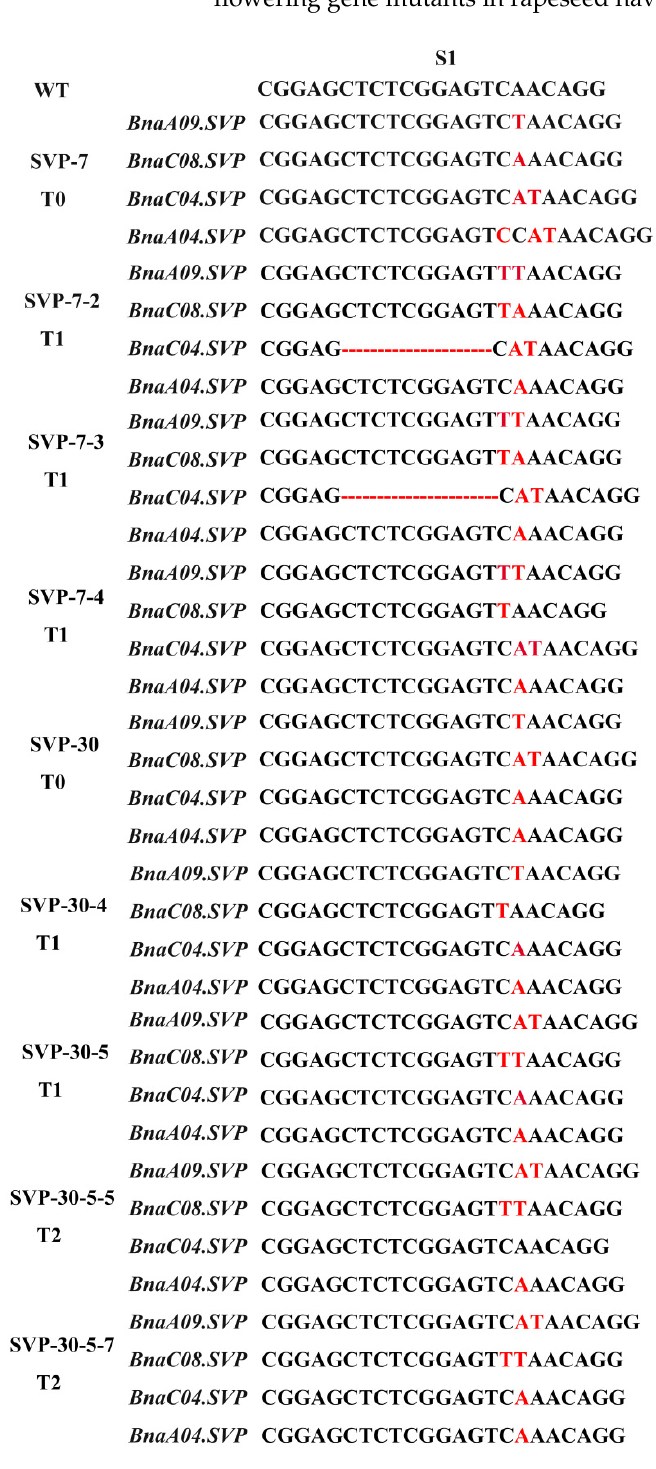
Figure 9. Genetic law of S1 and S2 target sites of BnaSVP . Red fonts represent insertion or substitution, red “-” represents deletions. S1 and S2 indicate target site 1 and target site 2, respectively. The CRISPR/Cas9 system has potential off-target effects, but numerous studies have shown that off-target effects can be ignored when sgRNAs have high specificity. The CRISPR/Cas9 system has good specificity for targeted mutations of B. napus , which can accurately mutate the genome sequence of B. napus [52,54,67,69,71]. Moreover, unneces- sary off-target effects in plants can be eliminated by hybridization with parents [72]. Therefore, off-target events were not considered in this study.